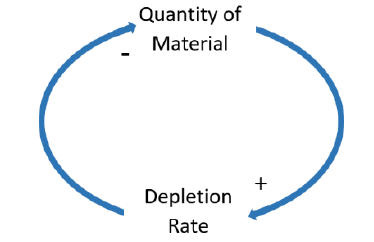
Fig. 6. Causal loop diagram for depletion